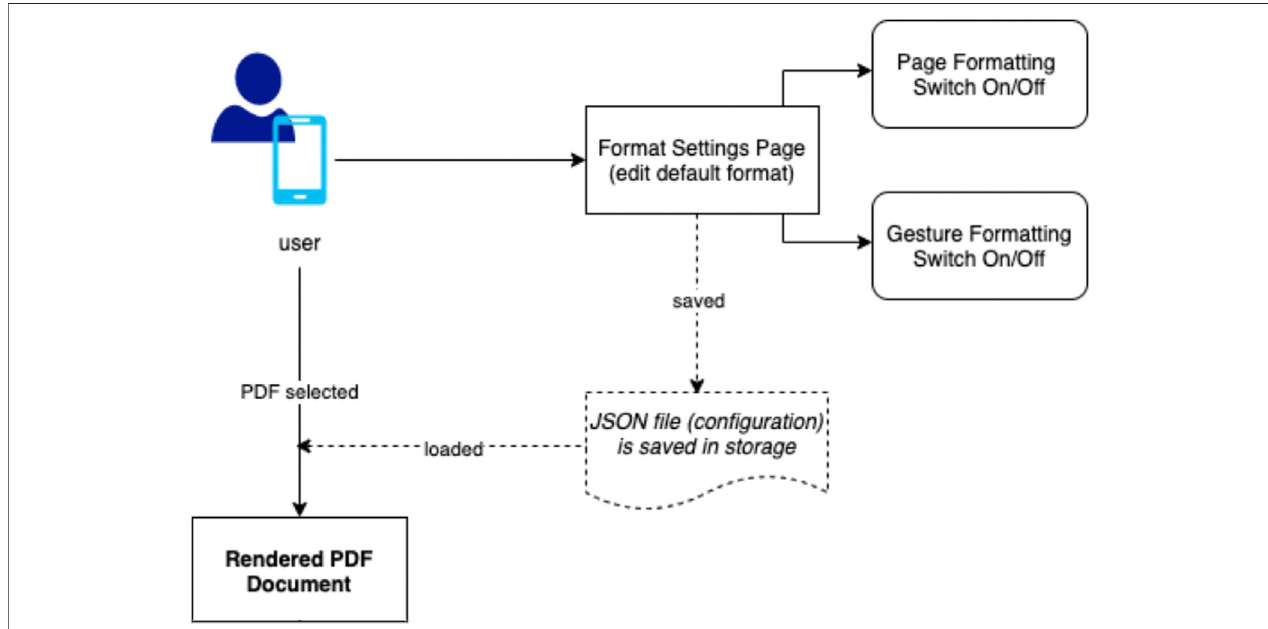
FIGURE 5 | Framework diagram.